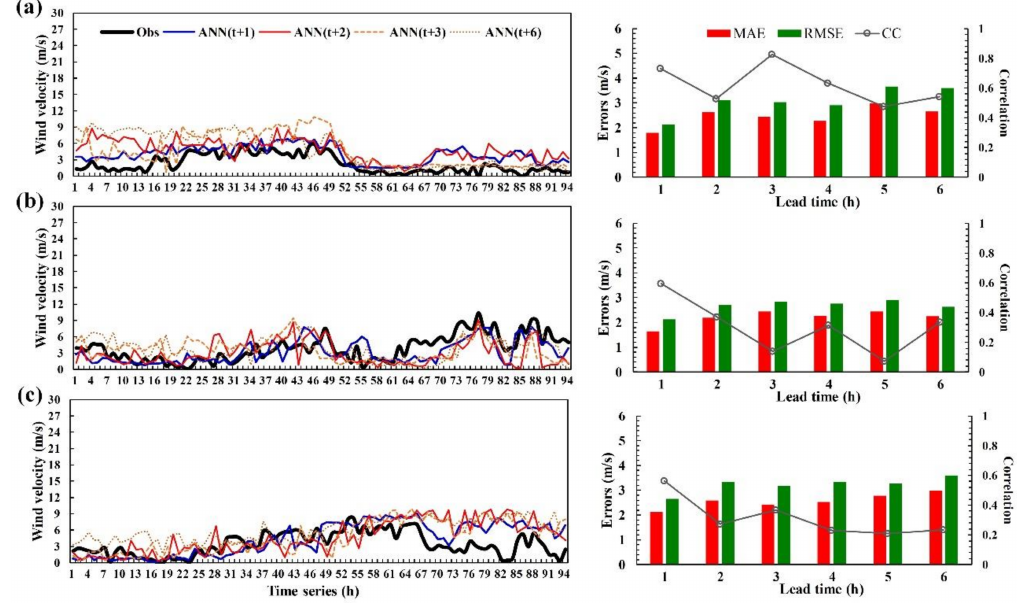
Figure 12. Comparisons between records and 1- to 6-h lead predictions for Nanmadol in 2011: ( a ) Hsinchu, ( b ) Wuqi, and ( c ) Kaohsiung